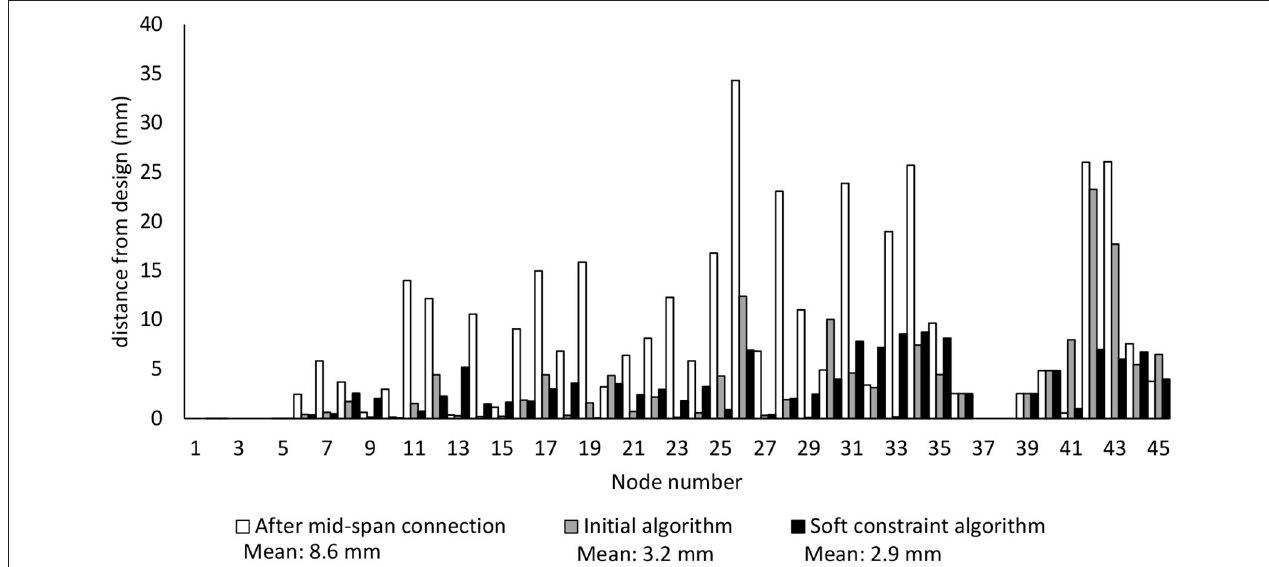
FIGURE 13 | Comparison of simulated nodal position distances [mm] after midspan connection, after application of the initial self-stress algorithm, and after application of self-stress soft-constraint algorithm.